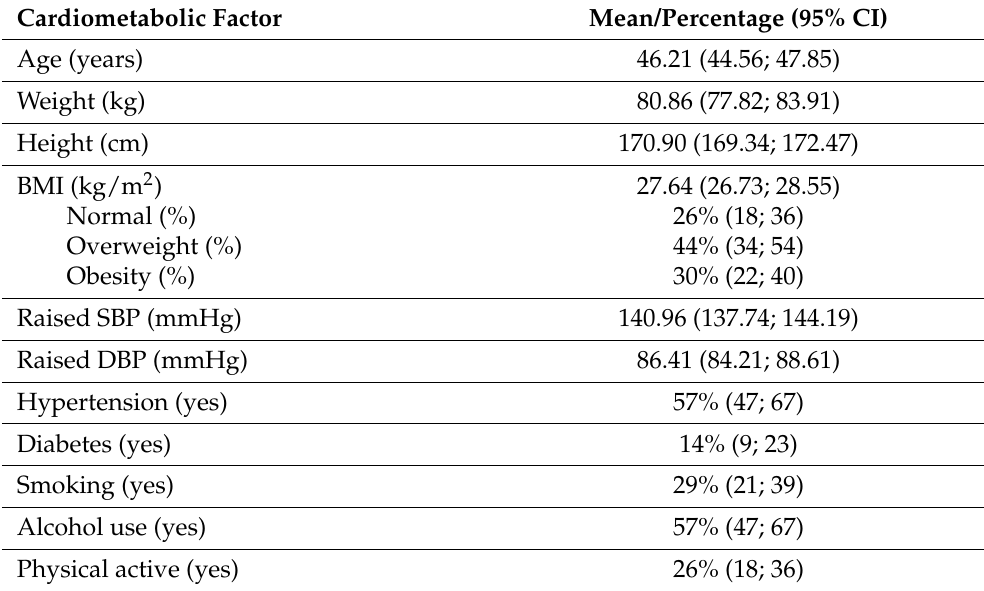
Table 1. Descriptive statistics of cardio-metabolic factor amongst logistic company truck drivers. Cardiometabolic